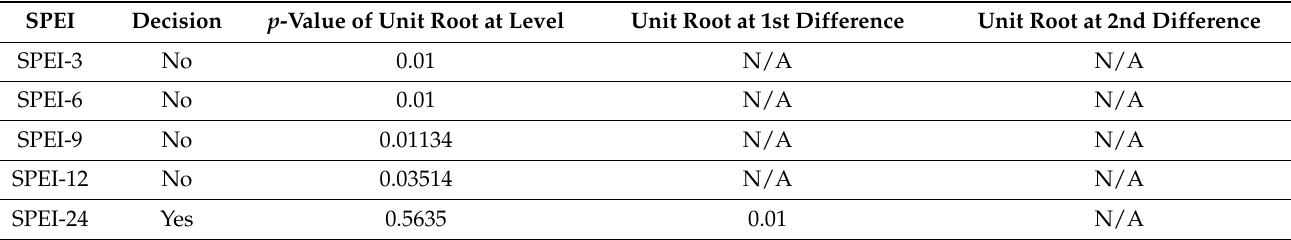
Table 3. Augmented Dickey–Fuller test.